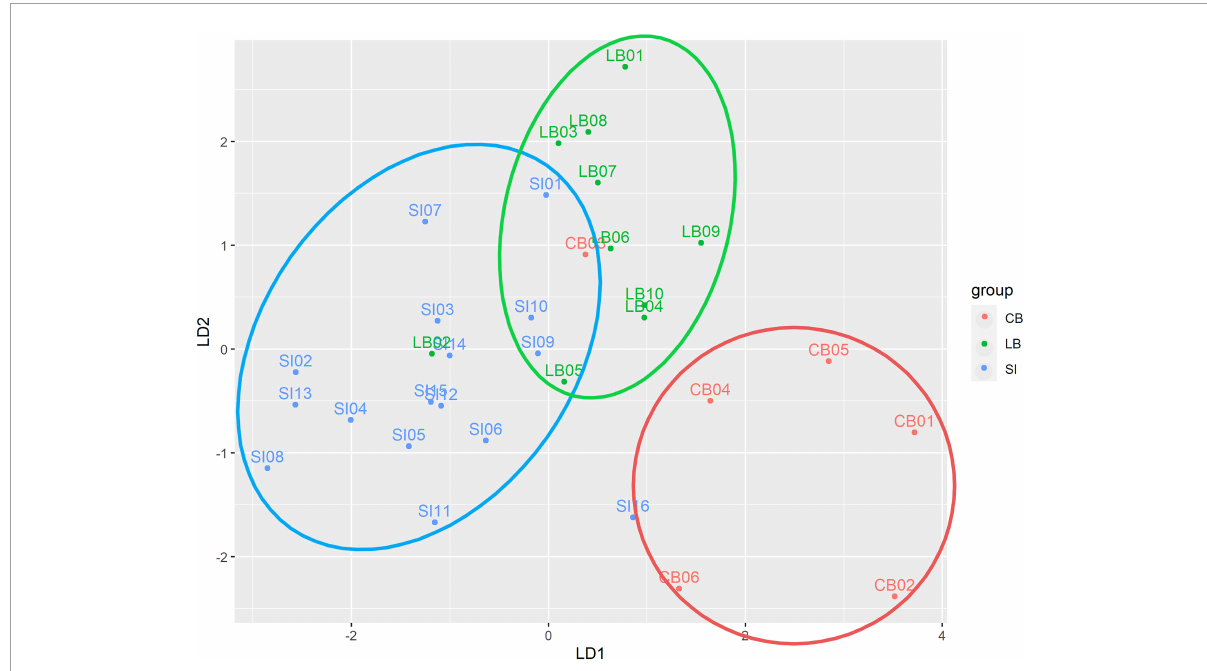
FIGURE2 Scatterplot of participants distribution in the two LDA dimensions. The diagram depicts congenitally blind (CB) as red circles, late blind (LB) as green circles and sighted controls (SI) as blue circles. The labels above each circle specify participants’ code. Ellipses indicate the three identified clusters. Note as the three groups tend to concentrate in different areas of the 2D space as defined by the two